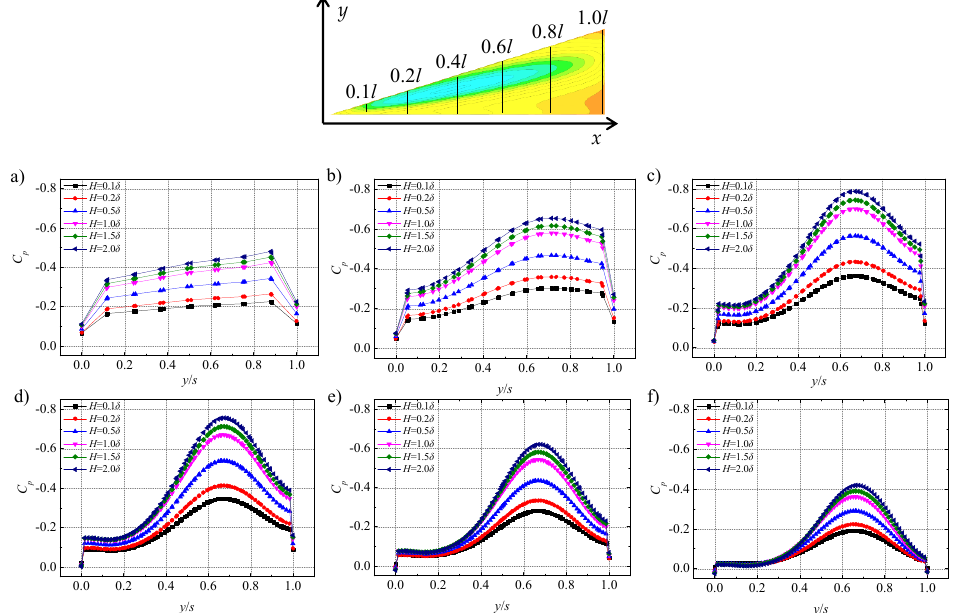
Figure 9. Distribution of static pressure coefficient on the leeward side of the VG ( a ) x = 0.1 l , ( b ) x = 0.2 l , ( c ) x = 0.4 l , ( d ) x = 0.6 l , ( e ) x = 0.8 l , ( f ) x = 1.0 l.